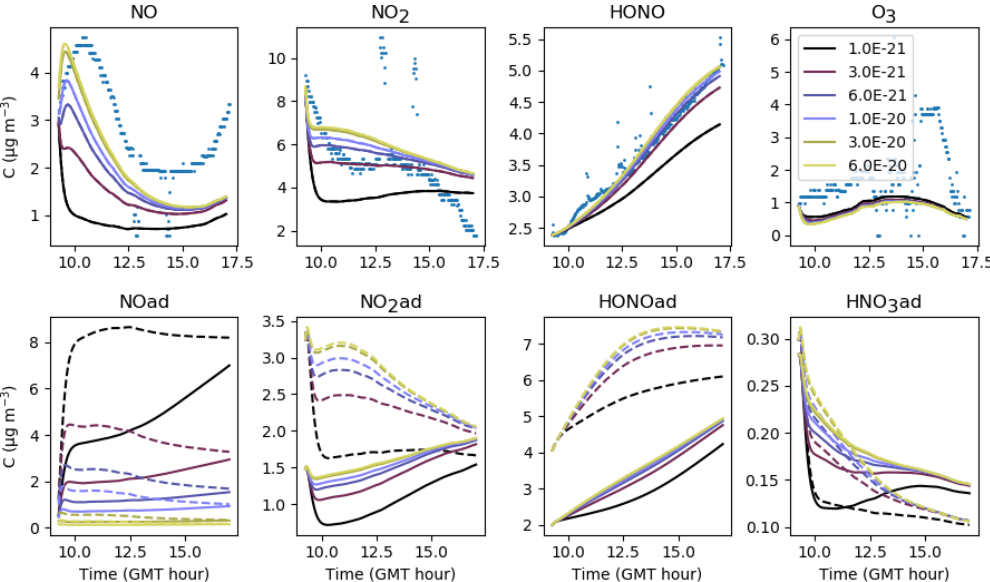
Figure 19. Gas-phase and adsorbed inorganic compounds simulated for different k (cid:48) ments (Experiment 3). The solid lines represent the concentrations in the sunlit box and the dashed lines the concentrations in the shaded box.